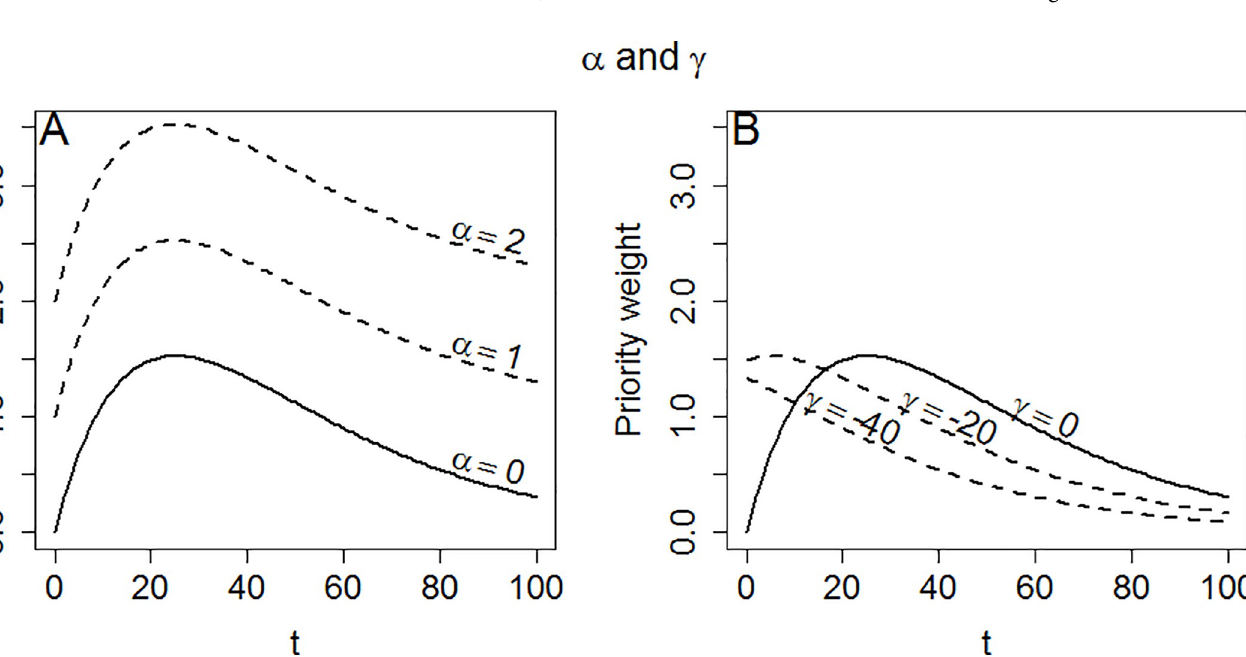
PLOS ONE | https://doi.org/10.1371/journal.pone.0223866 October 10,